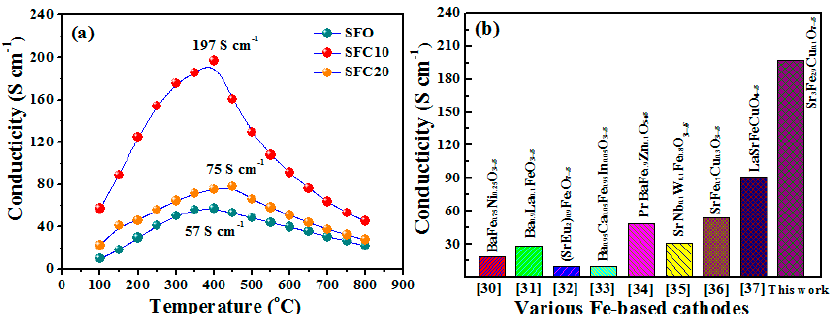
Figure 5. ( a ) Electrical conductivity of the SFC x materials at 100,800 °C; ( b ) maximum value of the conductivity for various Fe-based cathodes.